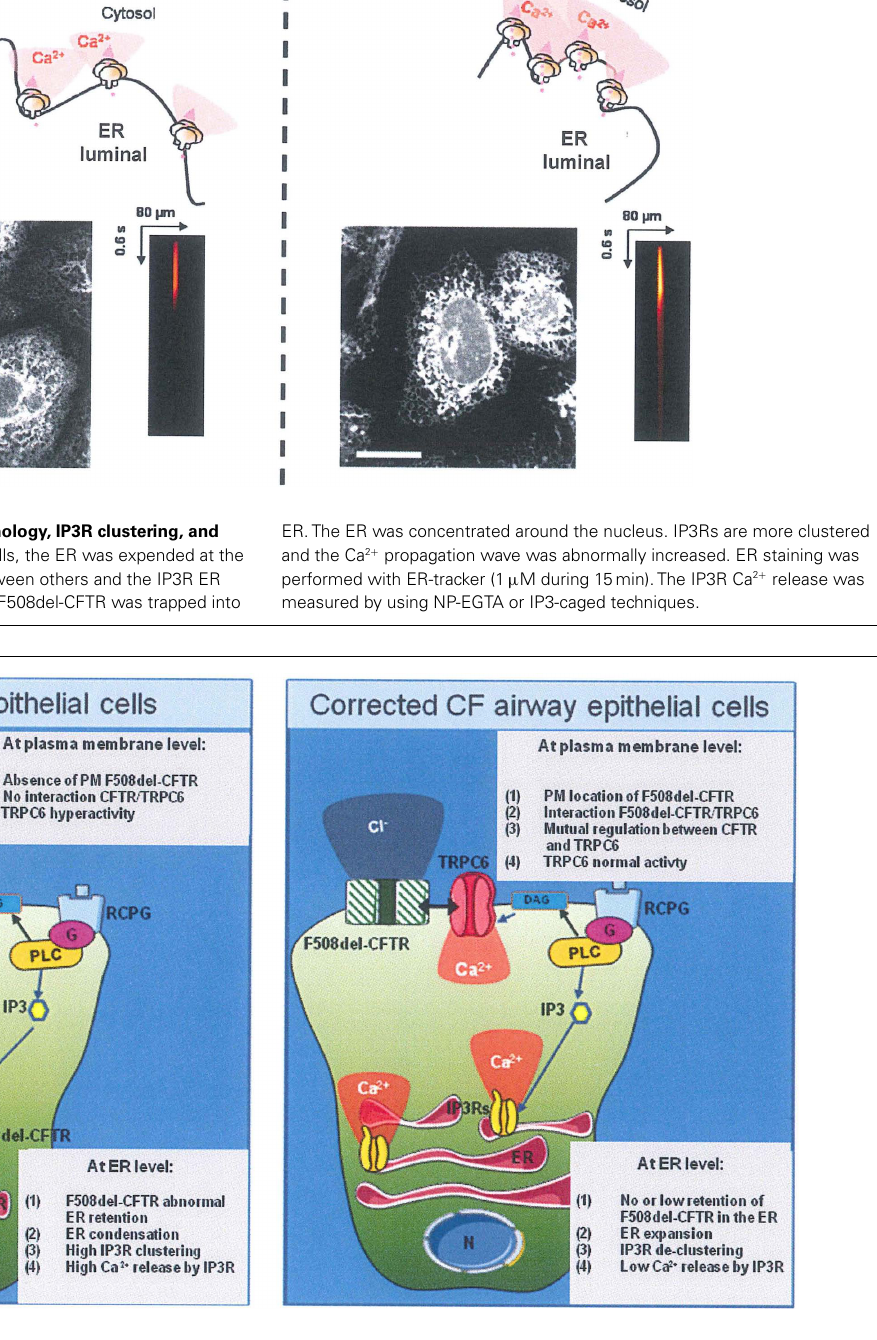
FIGURE 2 | Proposed model linking the F508del-CFTR mutation and Ca 2 + homeostasis in airway epithelial cell line. (Left panel) In CF airway epithelial phenotype, in absence of bacterial infection, the F508del-CFTR mutation caused the trapped of mutated CFTR protein into the ER, followed by the ER network condensation, inducing the IP3R clustering.The final consequence was the increased of IP3R activity. Moreover, the CFTR